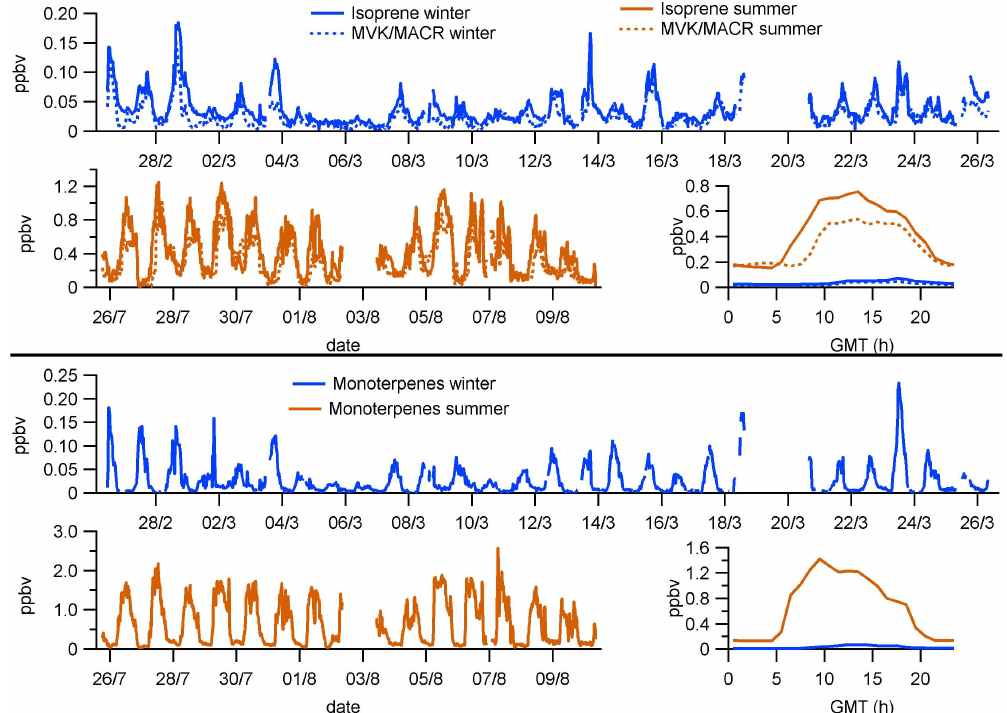
Fig. 6. Isoprenoid VOCs and MVK/MACR measured at MSY, showing their mixing ratios during the winter period (upper graph of each panel), their mixing ratios during the summer period (lower left graph) and their mean daily cycles (hourly averages) for both periods (lower right graph). Note the different scaling for the seasonal trend graphs. Date labels indicate 00:00